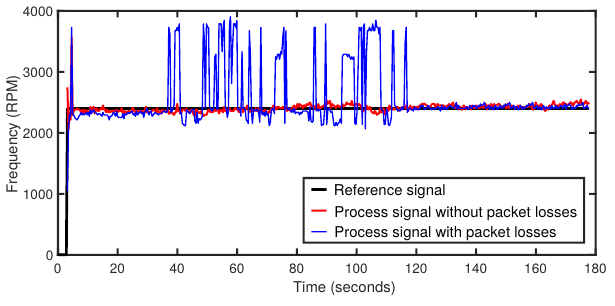
Figure 4. Set point at 2400 RPM. Table 2. Packet loss to each distance (Distance × Loss